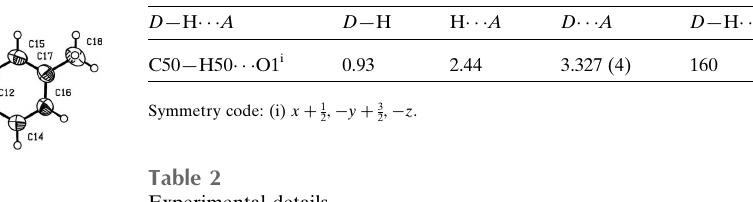
Table 2 Experimental details.